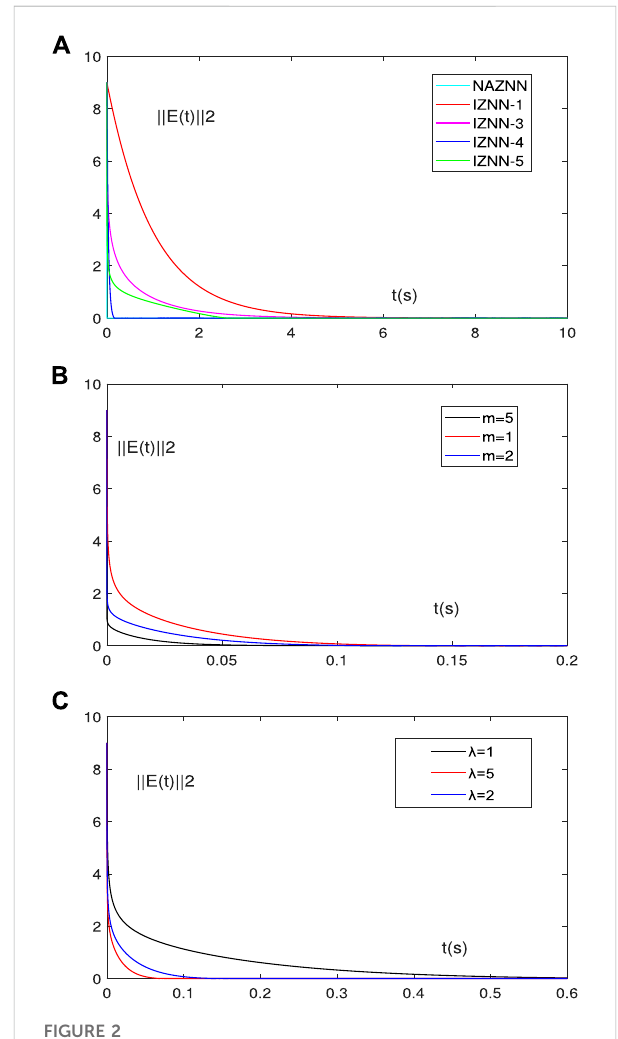
FIGURE 2 ComparativeexperimentsoftheZNNmodelsforsolvingEq.1. (A) is the residual errors of all the models, (B) is the residual errors of the NAZNN model with different parameter m, (C) is the residual errors of the NAZNN model with different parameter λ